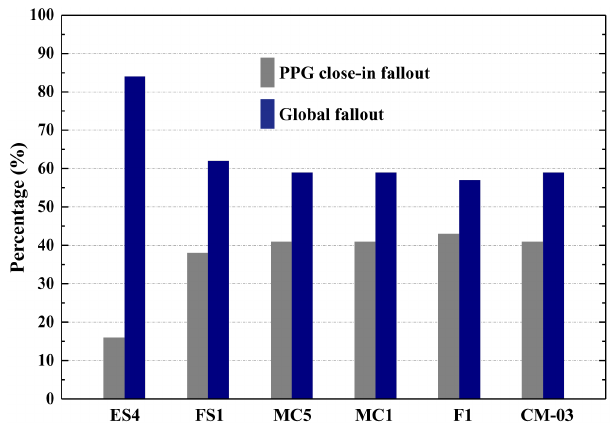
Fig. 6. The percentage of Pu that originated from global fallout and PPG close-in fallout in the sediment cores. The data for CM-03 were calculated from Zheng and Yamada